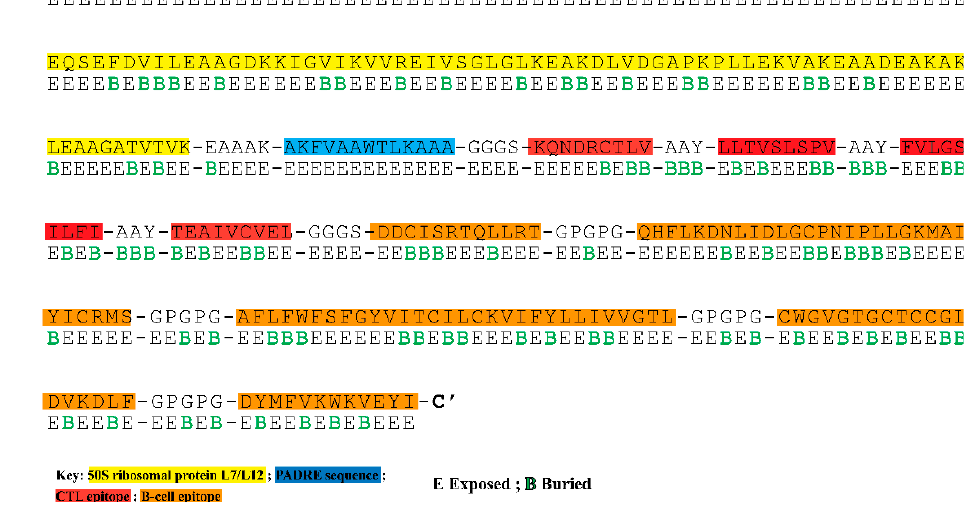
Figure 1. The amino acid sequence and surface accessibility of the constructed highlighted N-terminal has an attached adjuvant (50S ribosomal protein L7/L12) highlighted in yellow. The PADRE sequence is represented in dark blue colour. CTL, and B-cell epitopes are highlighted in red and orange. Surface accessibility (NetSurfP—3.0 sever) of each amino acid is shown as either exposed (E) or buried (B) residue.